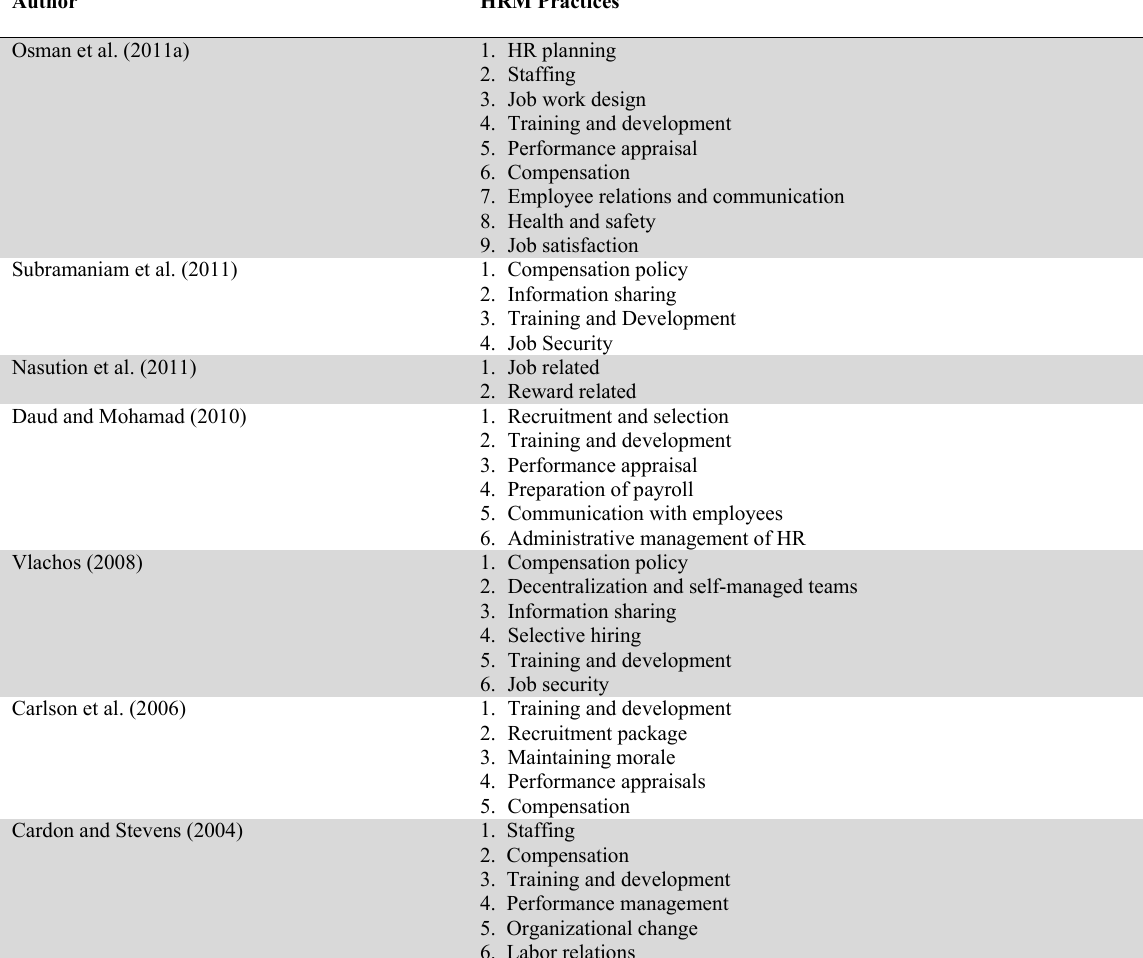
Summary of Best Practices in Human Resource Used by Different Studies in